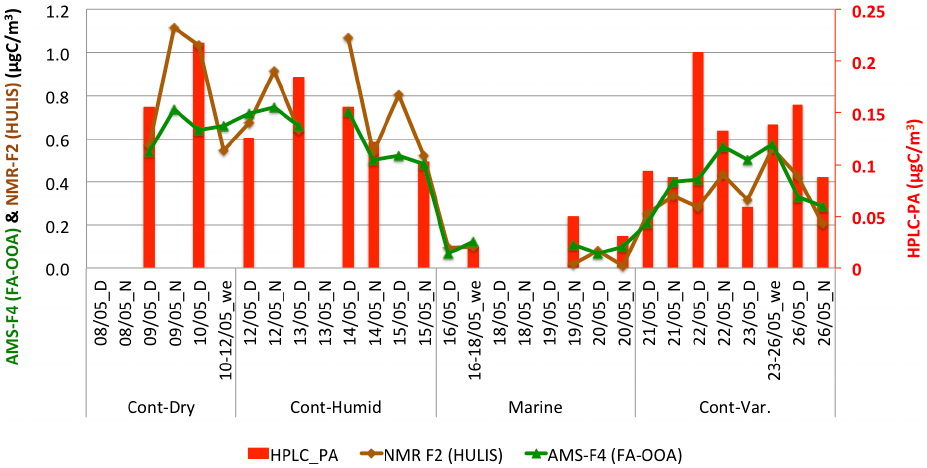
(left red axis). 2